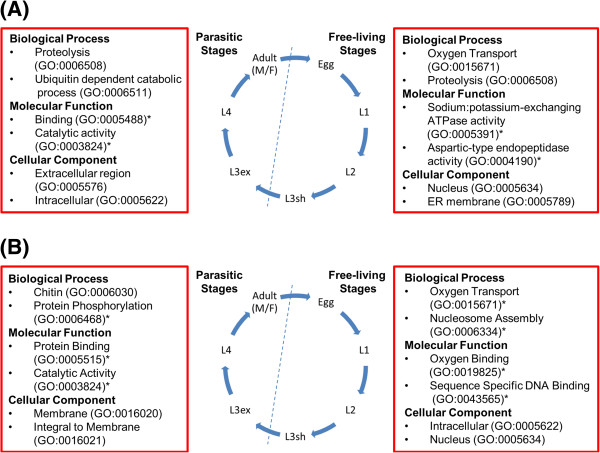
GO term associations with transcripts expressed in each stage. For each phase of the life cycle (free-living or parasitic) several prevalent GO terms are listed. * indicates a given term is significantly-enriched in that life cycle stage (p < 0.05). (A) C. oncophora; (B) O. ostertagi.